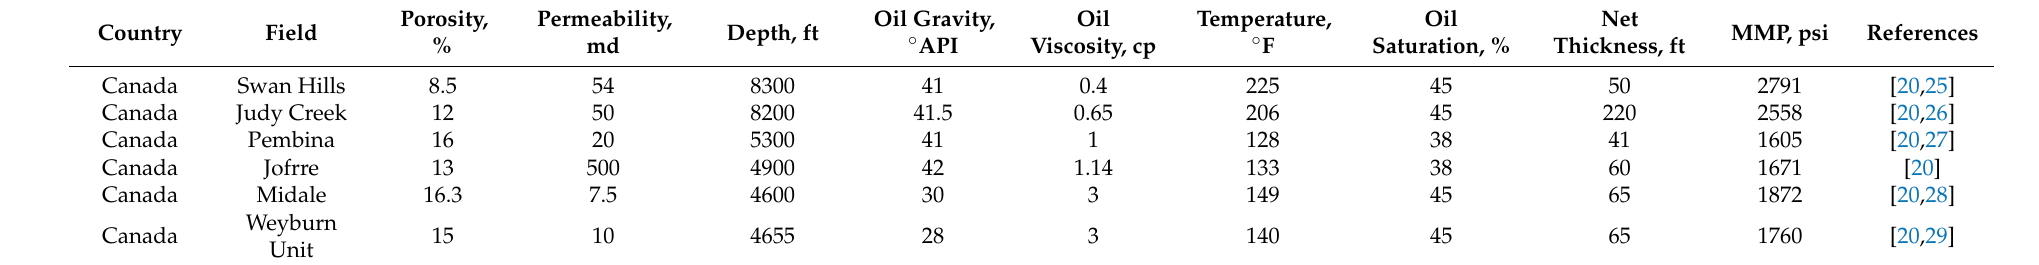
Table 5. Reservoir properties for implementation of miscible CO 2 -EOR screening.